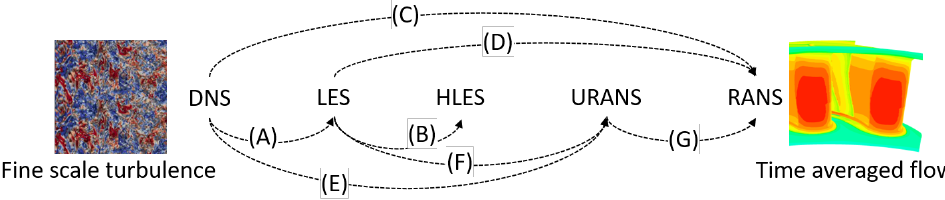
Figure 4. Schematic of the branches by which higher-fidelity scale-resolving simulations can be used as datasets to inform the development of lower-order